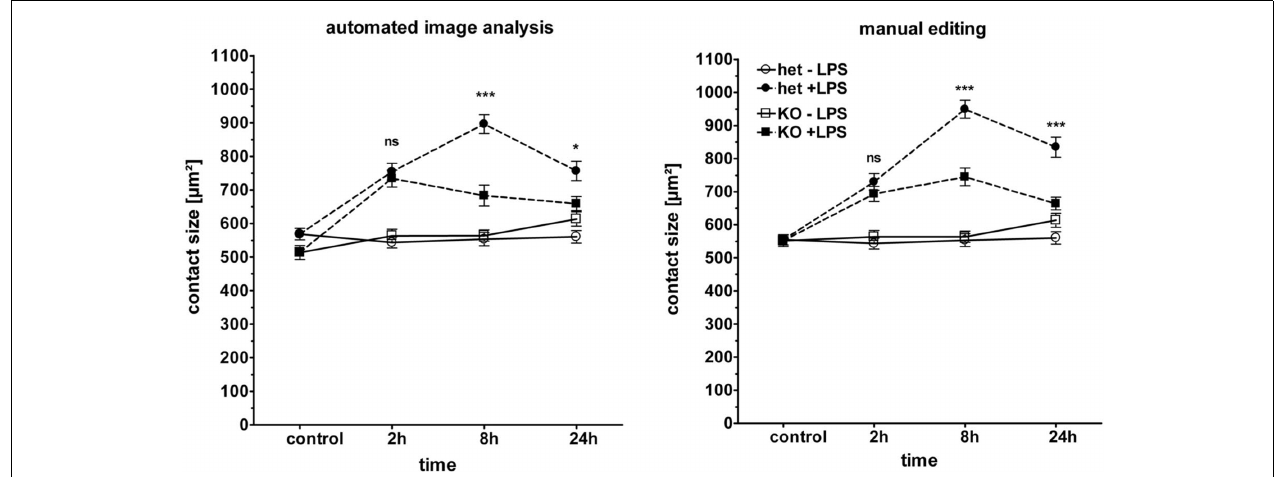
and SEM from one representative experiment of two performed. LPS (closed symbols), media control (open symbol), Myd88 ± (circles), Myd88 − / − (squares). Statistical significance refers to Myd88 ± compared to Myd88 − / − genotypes. ns = not significant; *** p < 0.0001.